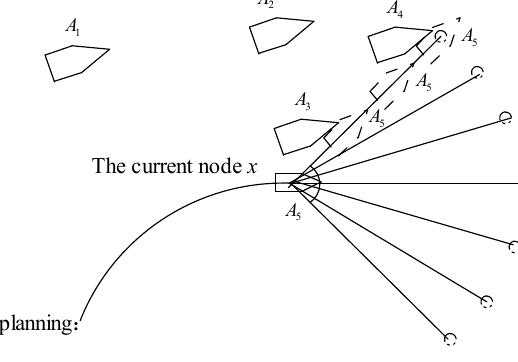
Figure 3. Diagram of the collision detection.